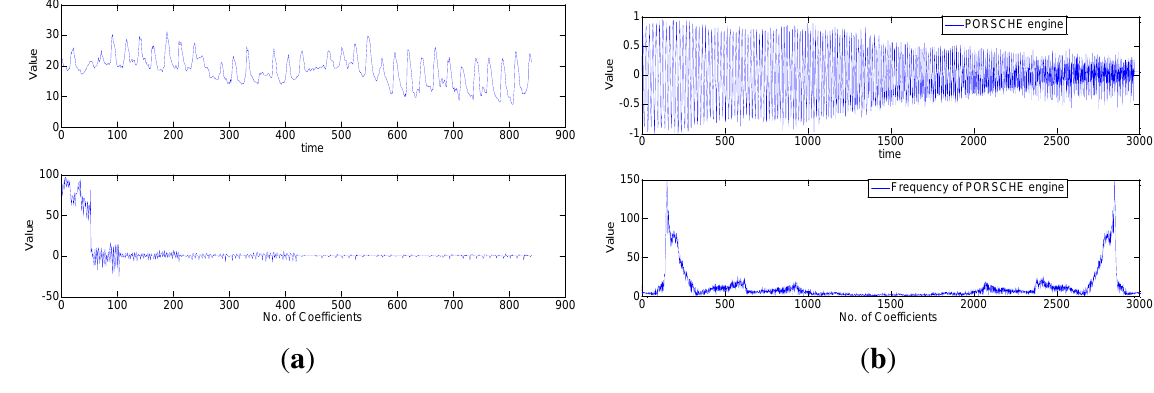
Figure 2. Signal sparsity in sensor networks. ( a ) Sparsity of CO Oakland; ( b ) sparsity of a car